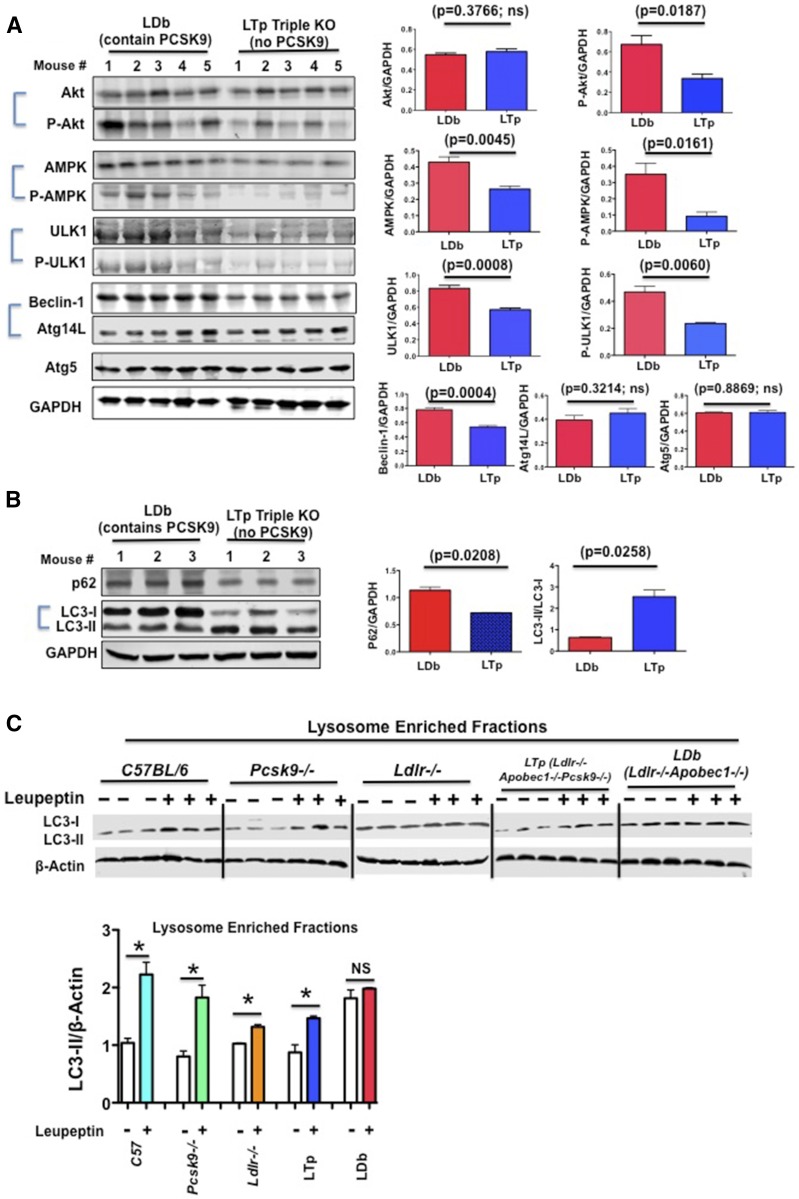
A: Deficiency of PCSK9 in LTp triple KO mice activates the hepatic autophagy signaling pathway. Equal amounts of liver homogenate proteins (50 μg) from overnight-fasted LDb male mice (n = 5) and LTp male mice (n = 5) at 5 months of age were resolved by SDS-PAGE, followed by Western blot to detect Akt, p-Akt, AMPK, p-AMPK, ULK1, p-ULK1, Beclin-1, Atg14L, Atg5, and GAPDH. Each protein was detected and quantified using an Odyssey infrared imaging system (Li-COR). The results are expressed as ratios of intensities of each protein (n = 5)/GAPDH (mean ± SEM). Statistical analyses were performed using two-tailed unpaired t-tests with Welch’s correction. ns, not significant. B: Deficiency of PCSK9 in LTp triple KO mice activates hepatic autophagy sequestration function. Equal amounts of liver homogenate proteins (50 μg) from overnight-fasted LDb (n = 3) and LTp (n = 3) male mice at 5 months of age were resolved by SDS-PAGE, followed by Western blot analysis to detect p62 and LC3-I/II. Each protein was detected and quantified using an Odyssey infrared imaging system (Li-COR). The results are expressed as ratios of intensities of each protein (n = 3)/GAPDH and LC3-II/LC3-I (mean ± SEM). Statistical analyses were performed using two-tailed unpaired t-tests with Welch’s correction. C: In vivo macroautophagic flux assay. PBS or leupeptin (40 mg/kg body weight) was administered to nonfasted C57BL/6J, Pcsk9−/−, Ldlr−/−, LDb, and LTp mice at 3 months of age. At 2 h after injection, livers were collected. LC3-I and LC3-II in liver lysosome-enriched fractions (30 μg/ml) were analyzed by SDS-PAGE, followed by Western blot. LC3-I was mostly not detectable. LC3-II was quantified using the Odyssey infrared imaging system. The results (LC3-II/β-actin) are expressed as mean ± SEM. Statistical analyses were performed using two-tailed unpaired t-tests with Welch’s correction. The assays were performed with three mice per genotype. A representative Western blot experimental set of each strain is shown here. *P < 0.05.